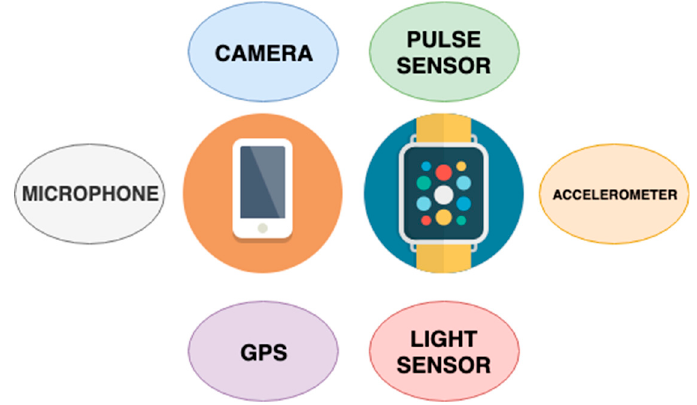
Figure 4. Mobile sensors.